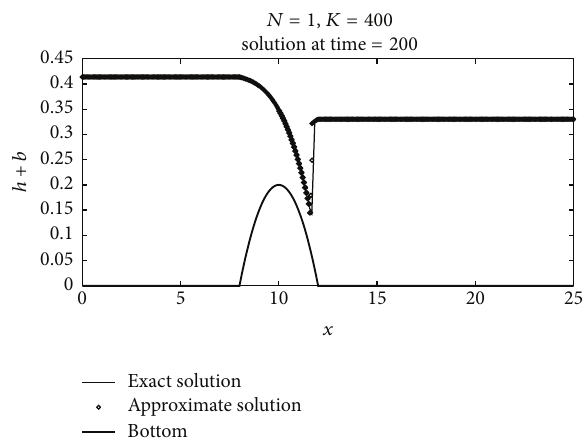
Figure 5: Transcritical flow with shock over a